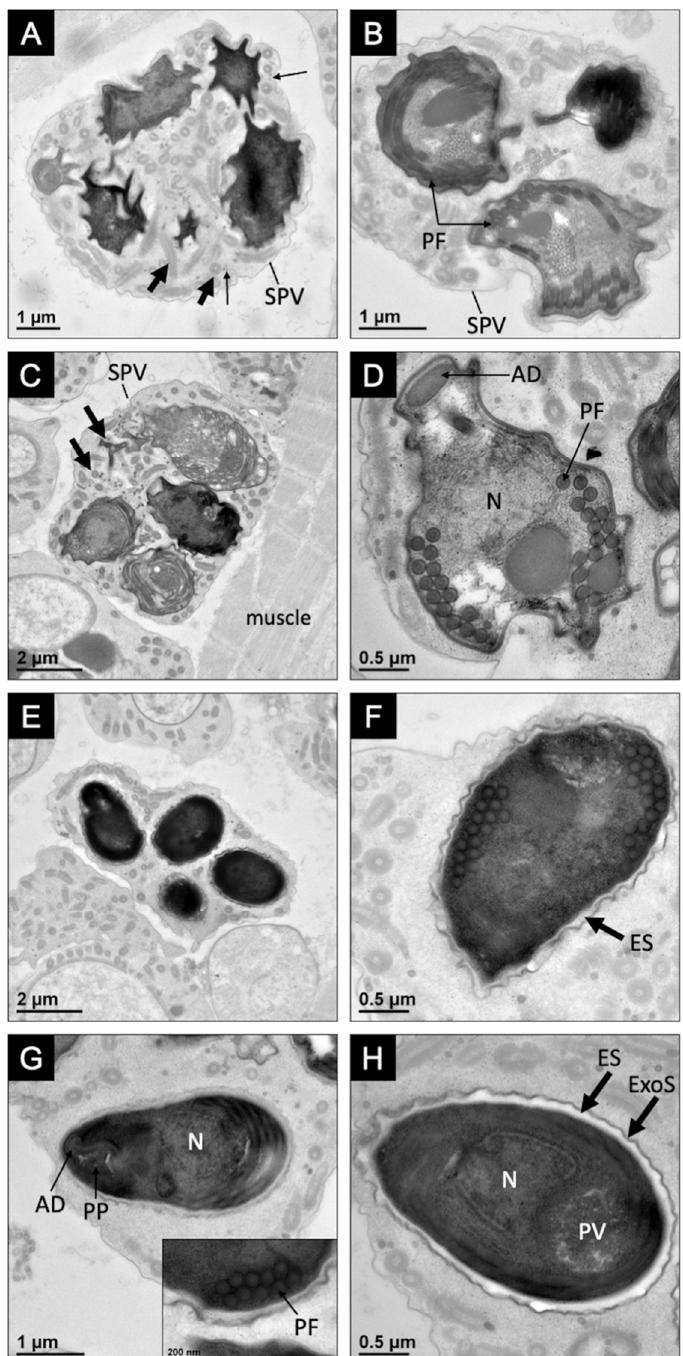
Figure 3. Sporogony and spore ultrastructure of Astathelohania virili n. sp. ( A ) Sporoblasts developing within a single sporophorous vesicle (SPV) that contains microtubular-like (small arrow) and tubular-like structures (large arrow); ( B ) sporoblasts beginning to develop electron-dense organelles including the polar filament (PF); ( C ) sporoblasts continuing to develop within SPV containing tubular-like structures (arrows) in close association with host muscle tissue; ( D ) a uninucleate (N) sporoblast with developing organelles including the anchoring disc (AD) and polar filament (PF); ( E ) near mature spores within an SPV; ( F ) spore with thickening endospore (ES); ( G ) uninucleate spore with a well-developed anchoring disc (AD) and bilaminar polarplast (PP). Inset shows fine details of polar filament and the two-layer arrangement; ( H ) a uninucleate spore with posterior vacuole and spore wall consisting of thickening electron-lucent endospore (ES) and electron-dense exospore (ExoS).